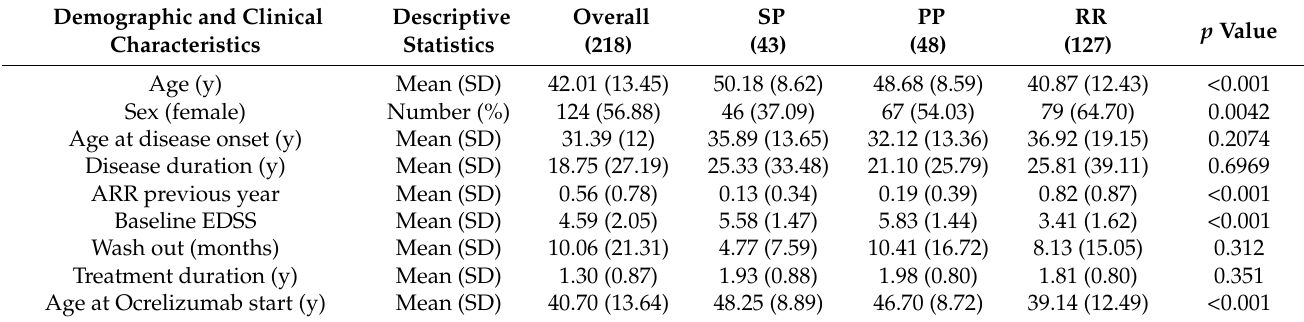
Table 1. Whole population’s demographic and clinical characteristics. Data are reported using standard descriptive statistics, mean ± standard deviation (sd), in the case of numerical variables, and absolute frequencies and percentages for categorical factors. All continuous data (mean ± standard deviation) are not normally distributed. Demographic and Clinical